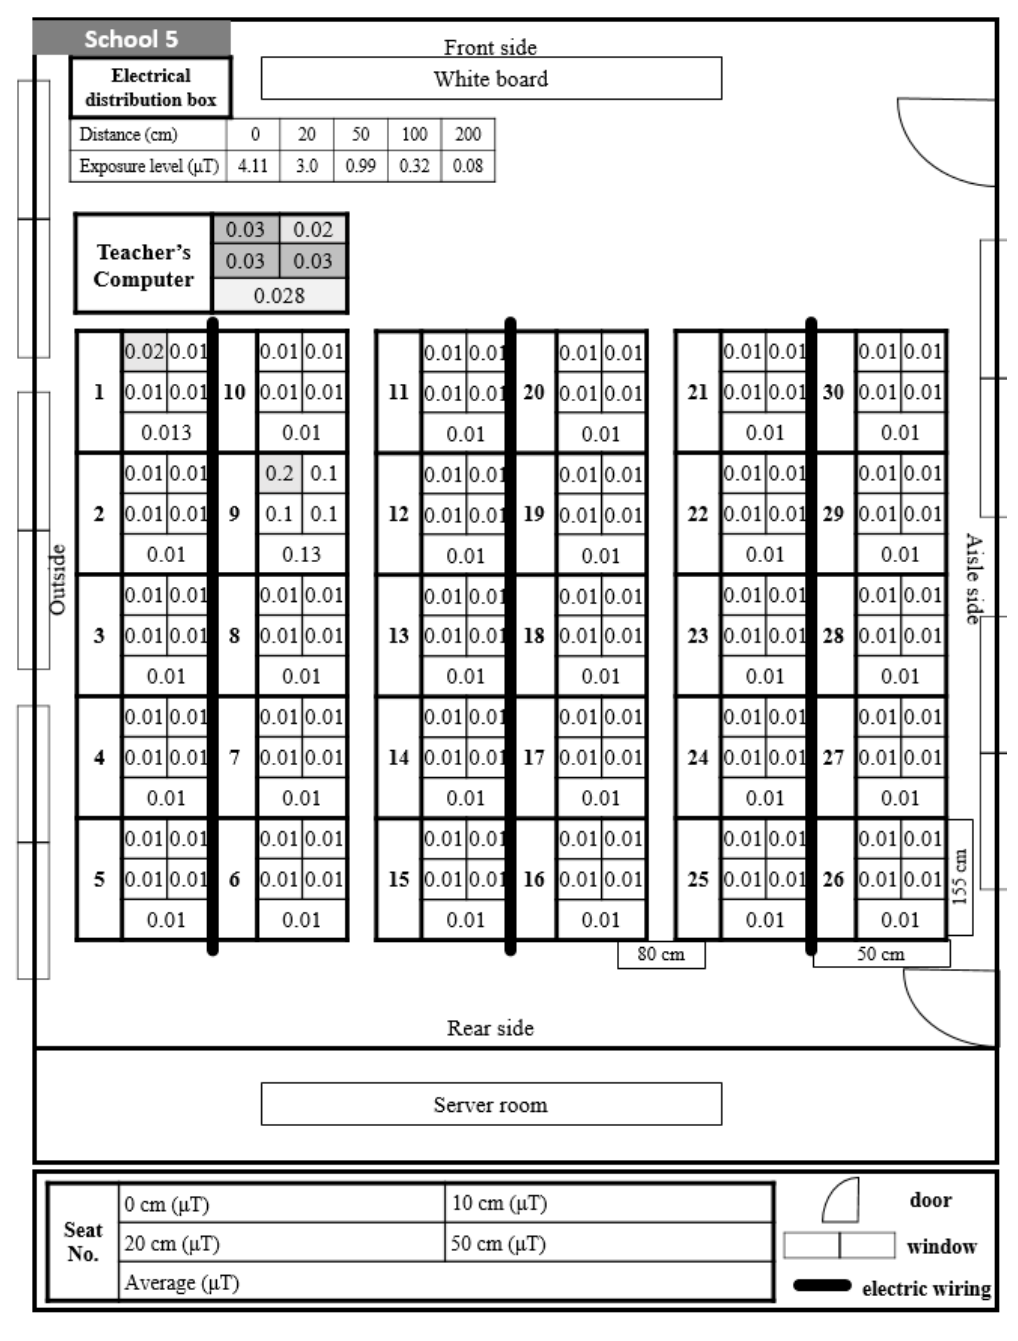
Figure 6. Distribution and exposure level of extremely low-frequency magnetic fields at each student seat in Classroom B at School 4. 0.01 is the lowest readout level, indicating < 0.01. The darkening of the space indicates that the level of ELF-MFs exposure increase by 0.01.